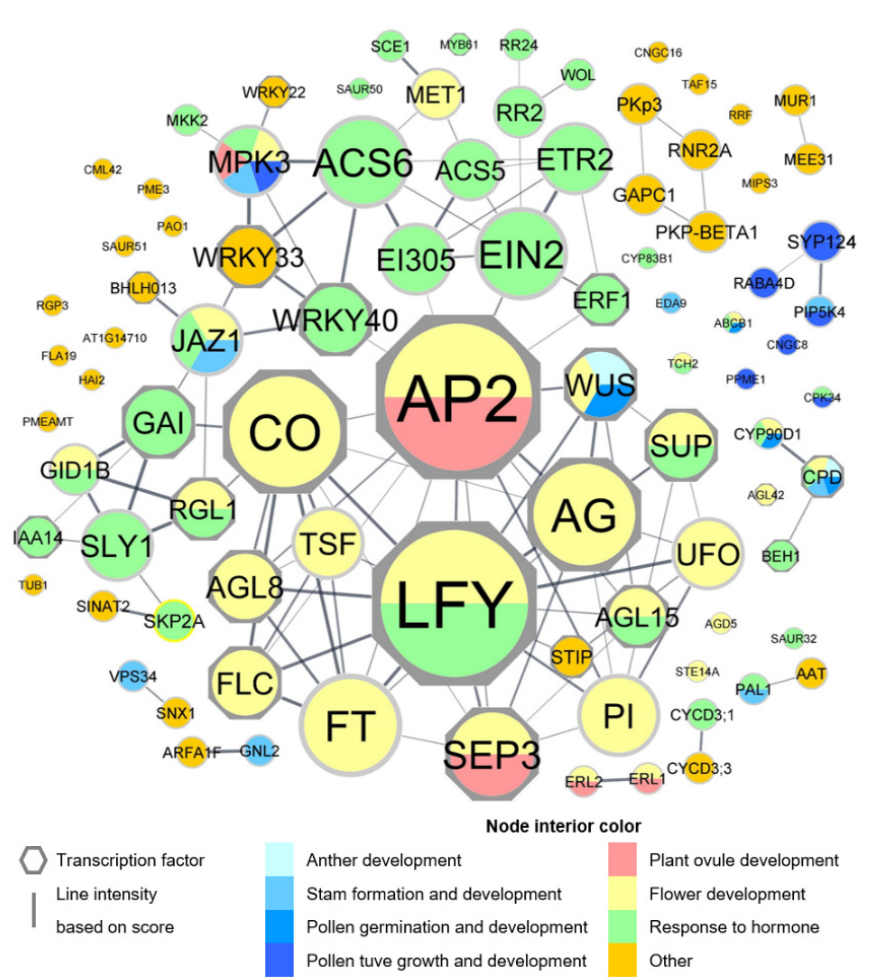
Figure 4. Protein-protein interaction (PPI) network of differentially expressed genes of the ‘Green Light’ × ‘Tomuri’ (G × T ) and Hayward (H ). The node represents the protein, the size of the node is proportional to the number of proteins that interact. the interaction with score > 0.6 were chosen for analysis.